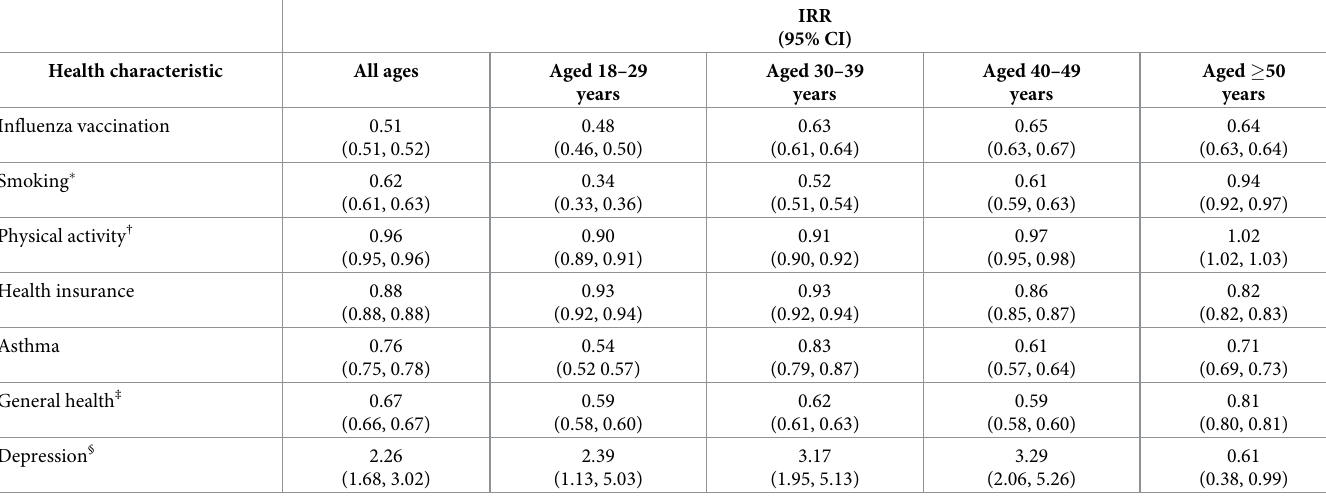
Table 3. Adjusted incidence of health characteristics between MTurk and national samples, overall and stratified by age